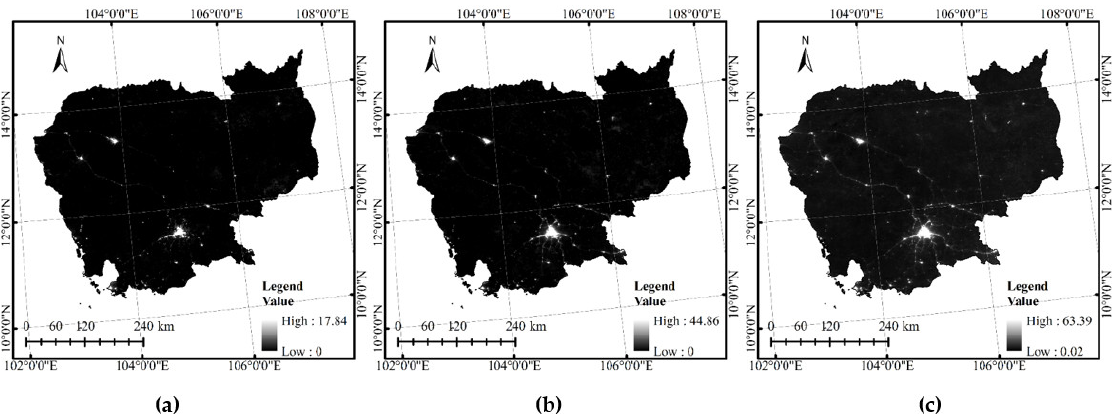
Figure 3. Annual night-light images of Cambodia obtained by the annual averaging method for years ( a ) 2012, ( b ) 2015, and ( c ) 2018.